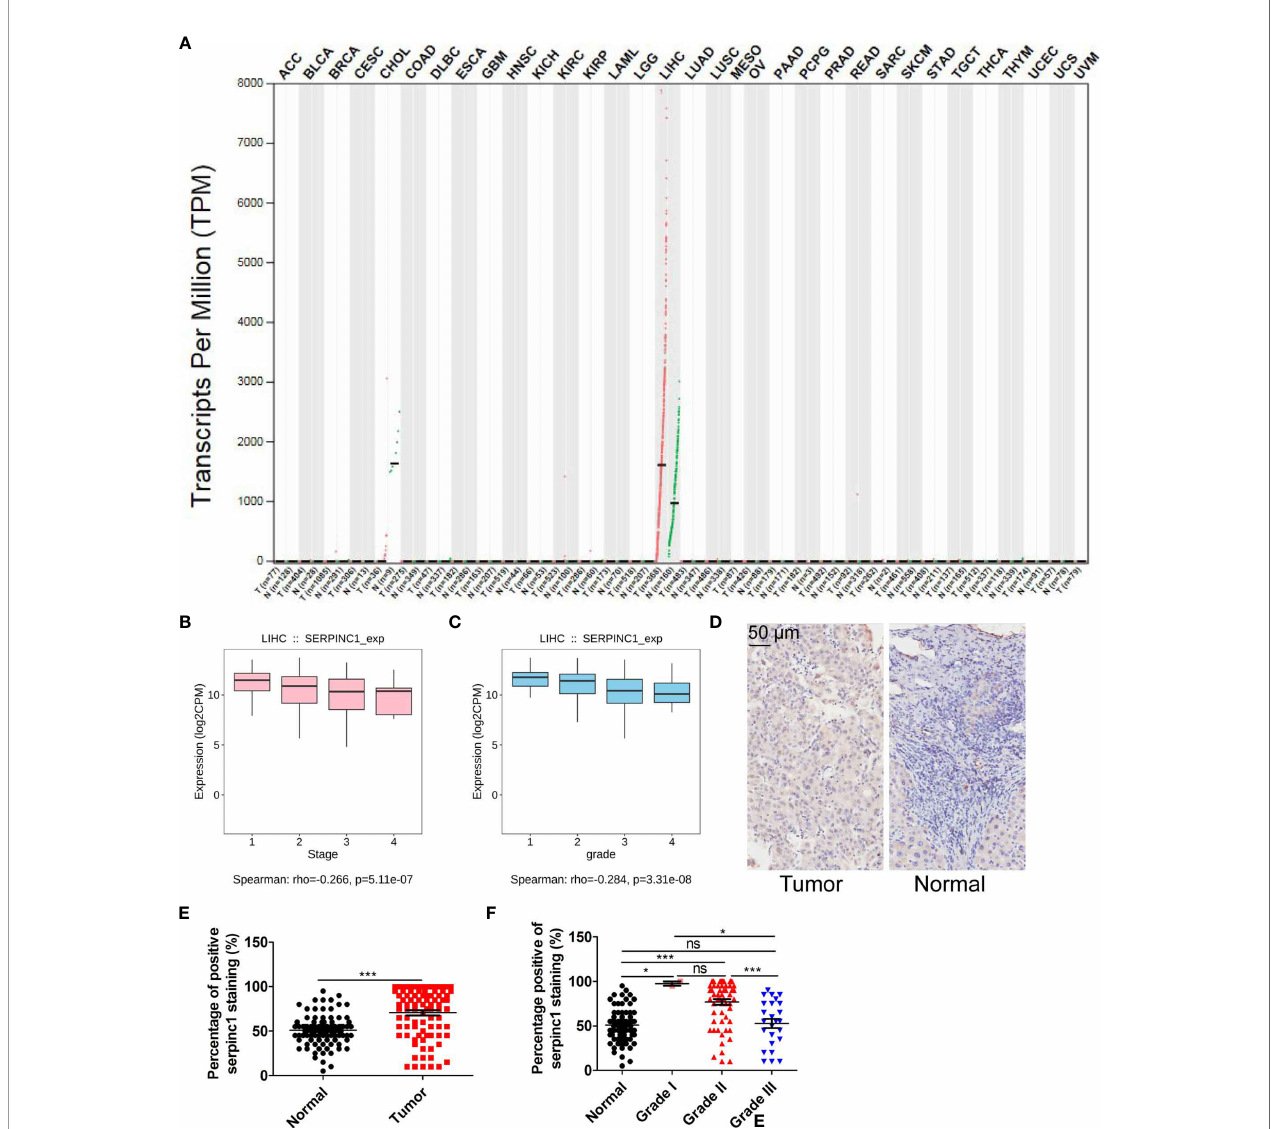
FIGURE 1 | Serpinc1 is increased in hepatocellular carcinoma. (A) Analysis of the serpinc1 mRNA expression across cancers from GEPIA database. (B, C) TISIDB database to analyze the correlation of serpinc1 mRNA expression with individual tumor stages (B) and tumor grade (C) . (D – F) Hepatocellular carcinoma (n=90) and normal tissues (n=90) were stained with serpinc1 antibody. Representative images (D) and statistical analysis the percentage of positive serpinc1 staining in normal and tumor groups (E) or different grade groups (F) . * P < 0.05, *** P < 0.001, ns, no signi fi cant, P >